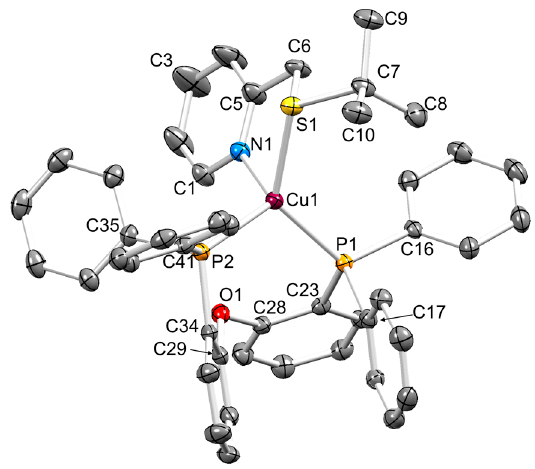
Figure 2. ORTEP-style diagram of the structure of the [Cu(POP)( t BuSPy)] + cation in [Cu(POP)( t BuSPy)][PF 6 ]. Ellipsoids plotted at 40% probability level and H atoms omitted for clarity. Selected bond parameters: Cu1–S1 = 2.3332(7), Cu1–N1 = 2.099(2), Cu1–P1 = 2.2584(7), Cu1–P2 = 2.2817(8), C6–S1 = 1.823(3), C7–S1 = 1.856(3), C28–O1 = 1.400(3), C29–O1 = 1.395(3) Å; S1–Cu1–N1 =